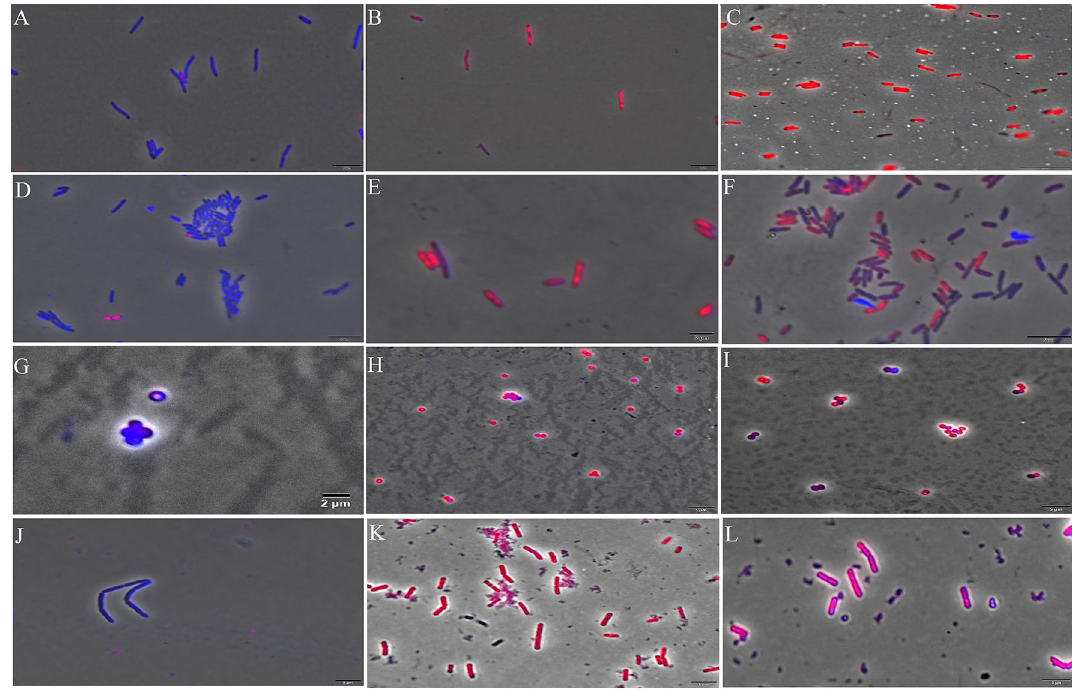
Figure 6. Fluorescence microscopy in cells stained with DAPI and PI after 15 min of exposure to ZnO NPs. Cells with intact membranes are artificially stained in blue, while cells with damaged membranes are stained in red. ( A ) E. coli (ATCC 8739) cells in nutrient broth medium (negative control); ( B ) E. coli (ATCC 8739) cells treated with heat-shock stress (positive control); ( C ) E. coli (ATCC 8739) cells treated with ZnO NPs at IC 100 ; ( D ) P. aeruginosa (ATCC 27853) cells in nutrient broth medium (negative control); ( E ) P. aeruginosa (ATCC 27853) cells treated with heat-shock stress (positive control); ( F ) P. aeruginosa (ATCC 27853) cells treated with ZnO at IC 100 ; ( G ) S. aureus (ATCC 6538) cells in nutrient broth medium (negative control); ( H ) S. aureus (ATCC 6538) cells treated with nisin at 5 µg mL −1 (positive control) ( I ) S. aureus (ATCC 6538) cells treated with ZnO at IC 100 ; ( J ) B. subtilis (ATCC 19659) cells in nutrient broth medium (negative control); ( K ) B. subtilis (ATCC 19659) cells treated with nisin at 5 µg mL −1 (positive control); ( L ) B. subtilis (ATCC 19659) cells treated with ZnO at IC 100 . Scale bar 2 μm; × 100